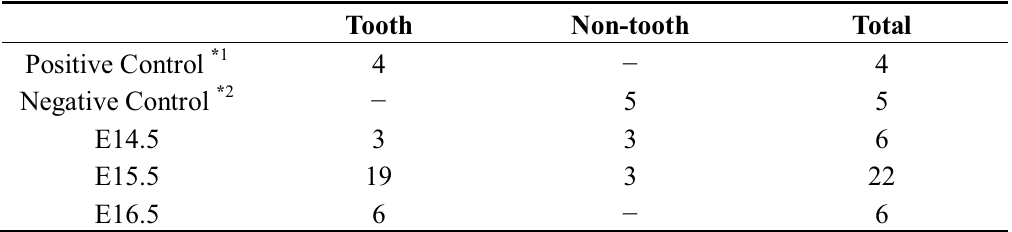
Table 3. Tissues grown from tooth germs reconstructed with emtg-2 cells and